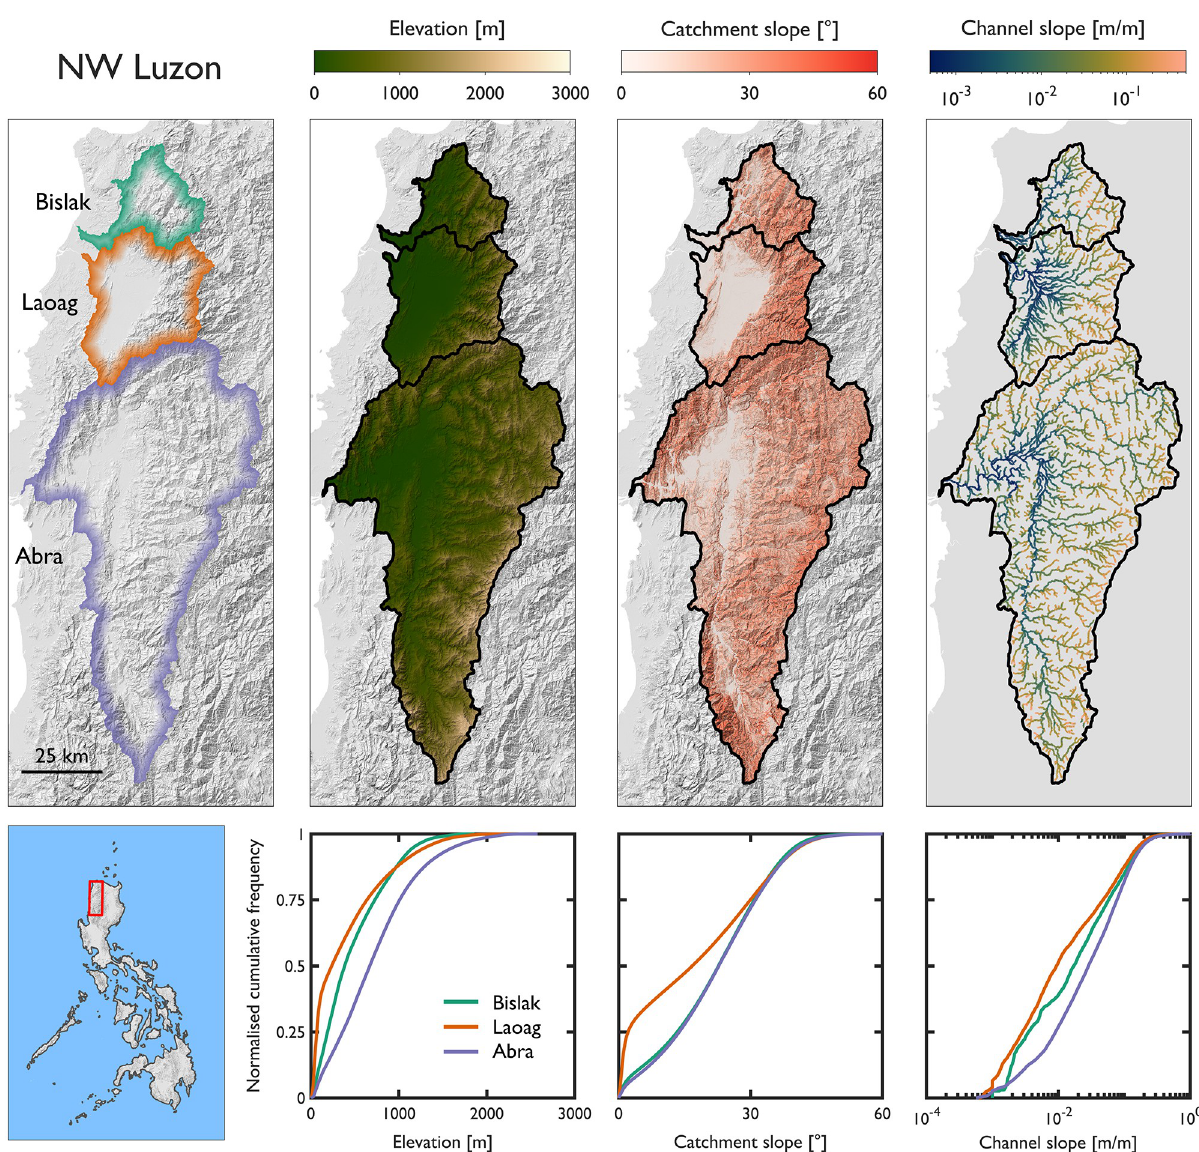
Fig 7. Inter-catchment comparisons of topographic diversity for three catchments in NW Luzon, the Philippines. All catchments have headwaters in the Cordillera Central of Ilocos Norte.